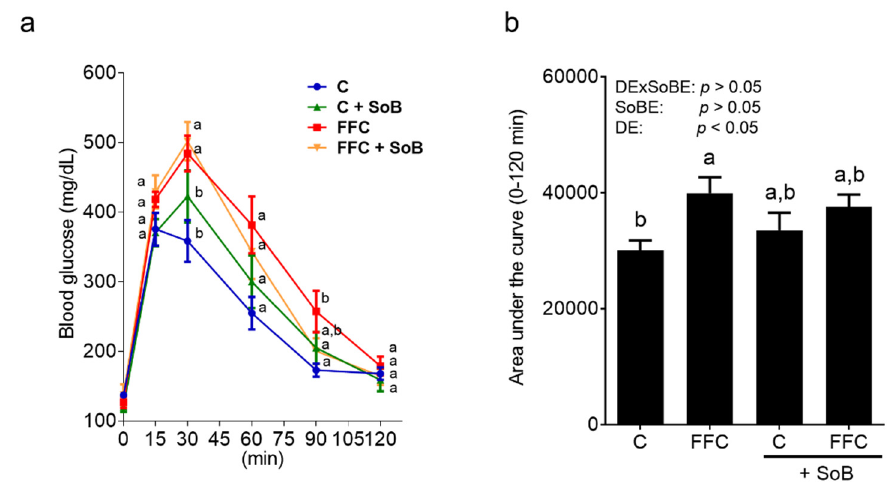
Figure 3. Effect of supplementation of SoB on glucose metabolism in mice with FFC-induced NASH. ( a ) Blood glucose levels during glucose tolerance test (GTT) and, ( b ) quantitative analysis of area under the curve of GTT (0-120 min). Data are expressed as means ± SEM, n = 8. Data with different letters are significantly different, p < 0.05. C, control diet; DE, diet effect; DExSoBE, interaction between diet and SoB; FFC, fat-, fructose-, and cholesterol-rich diet; NASH, non-alcoholic steatohepatitis; SoB, sodium butyrate; SoBE; sodium butyrate effect.